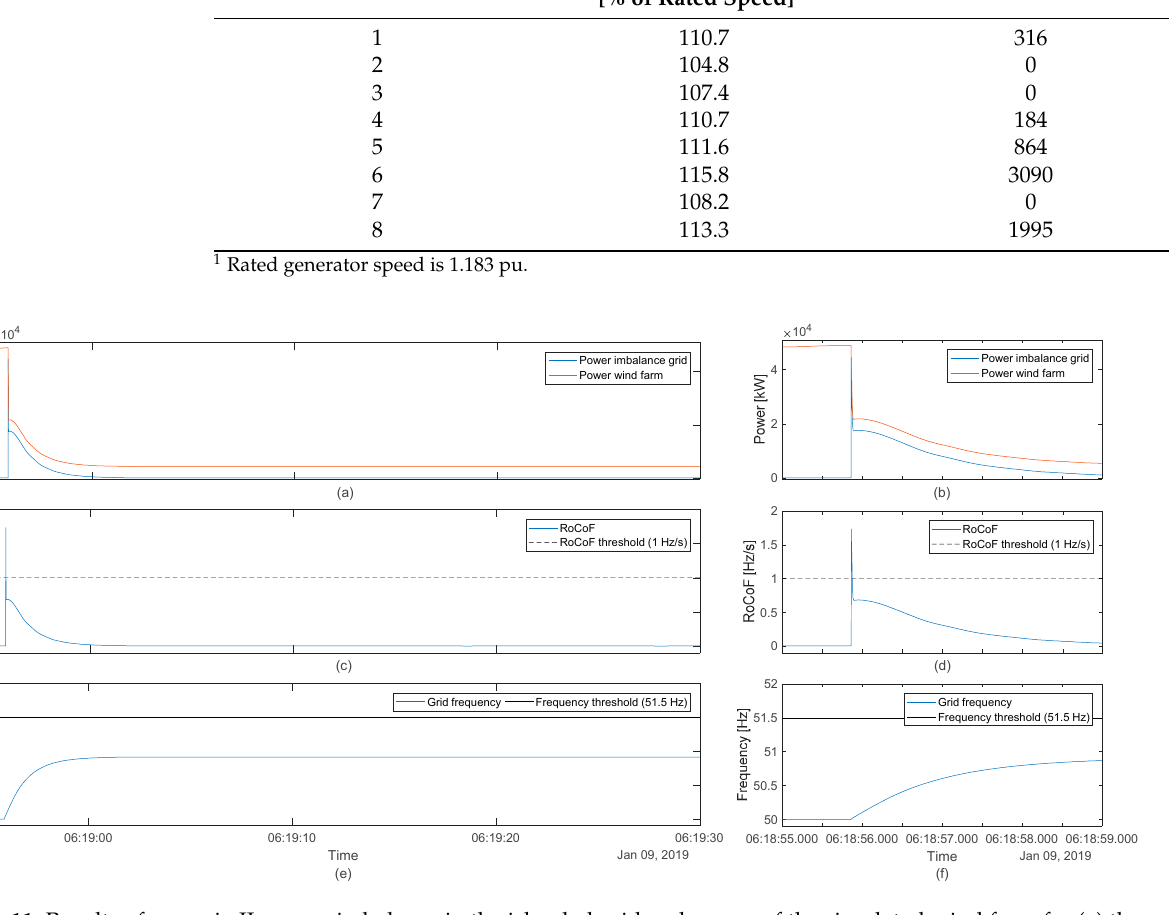
Figure 10. Simulation results of scenario I for four WTs: ( a ) Wind speed and rated wind speed; ( b ) Generator power; ( c ) generator speed, speed setpoint, and overspeed threshold. The time axis of ( c ) is valid for the above subplots as well.